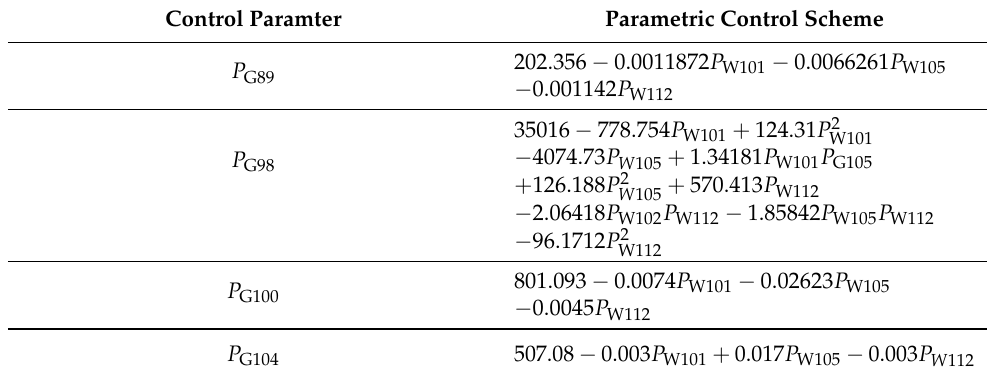
Table 3. Parametric Control Scheme of the IEEE 145-bus system